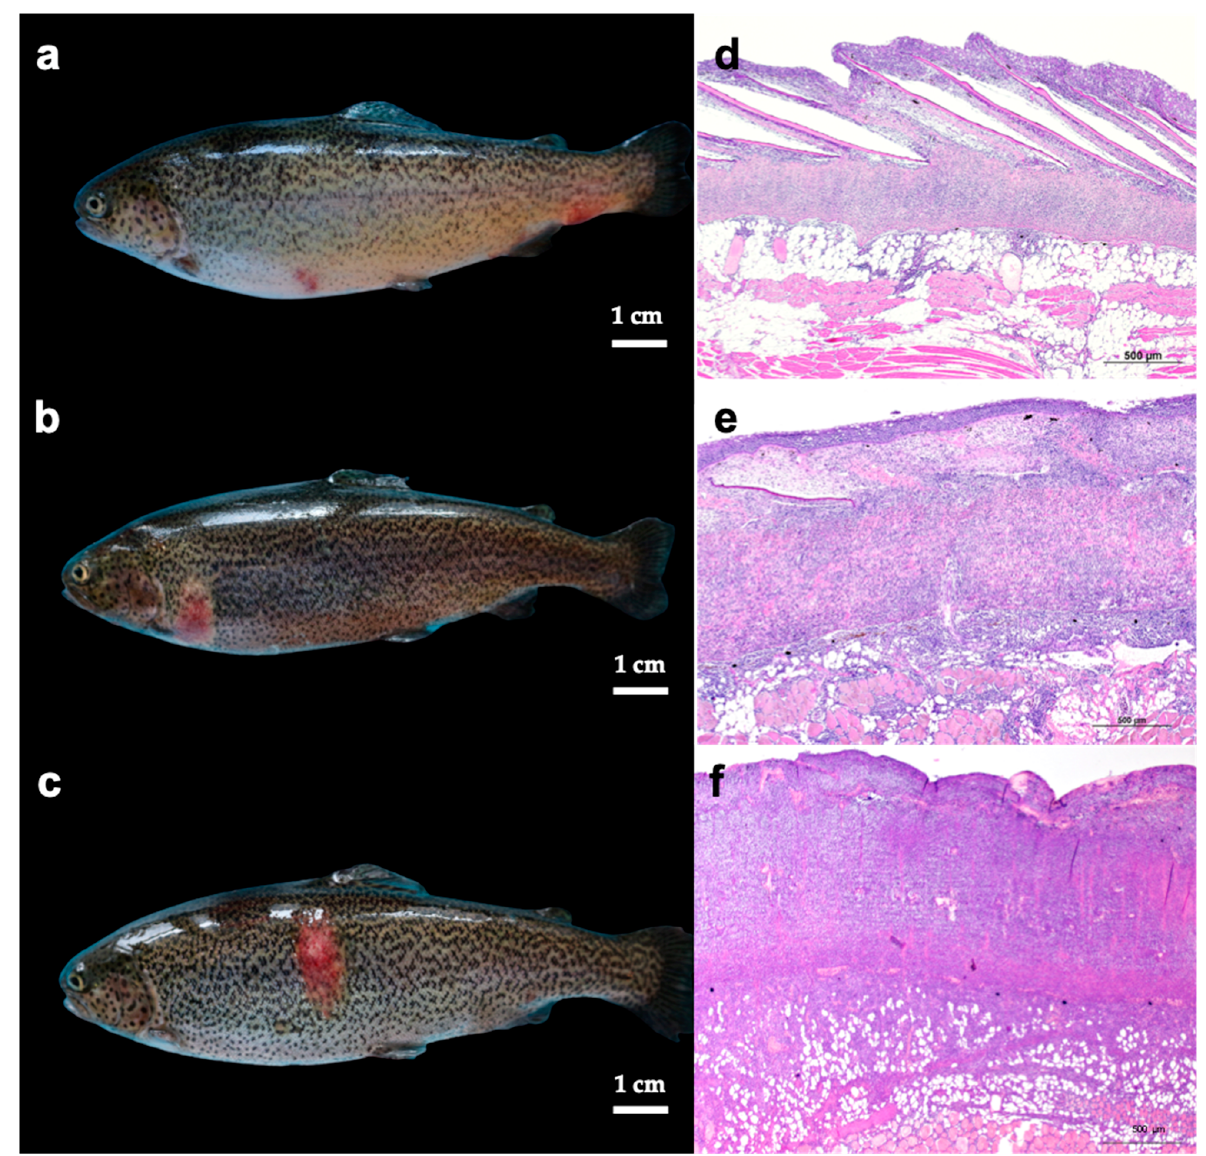
Figure 1. ( a – f) . Gross skin lesions ( a – c ) and their histological classi fi cation (H&E, ( d – f )) included in